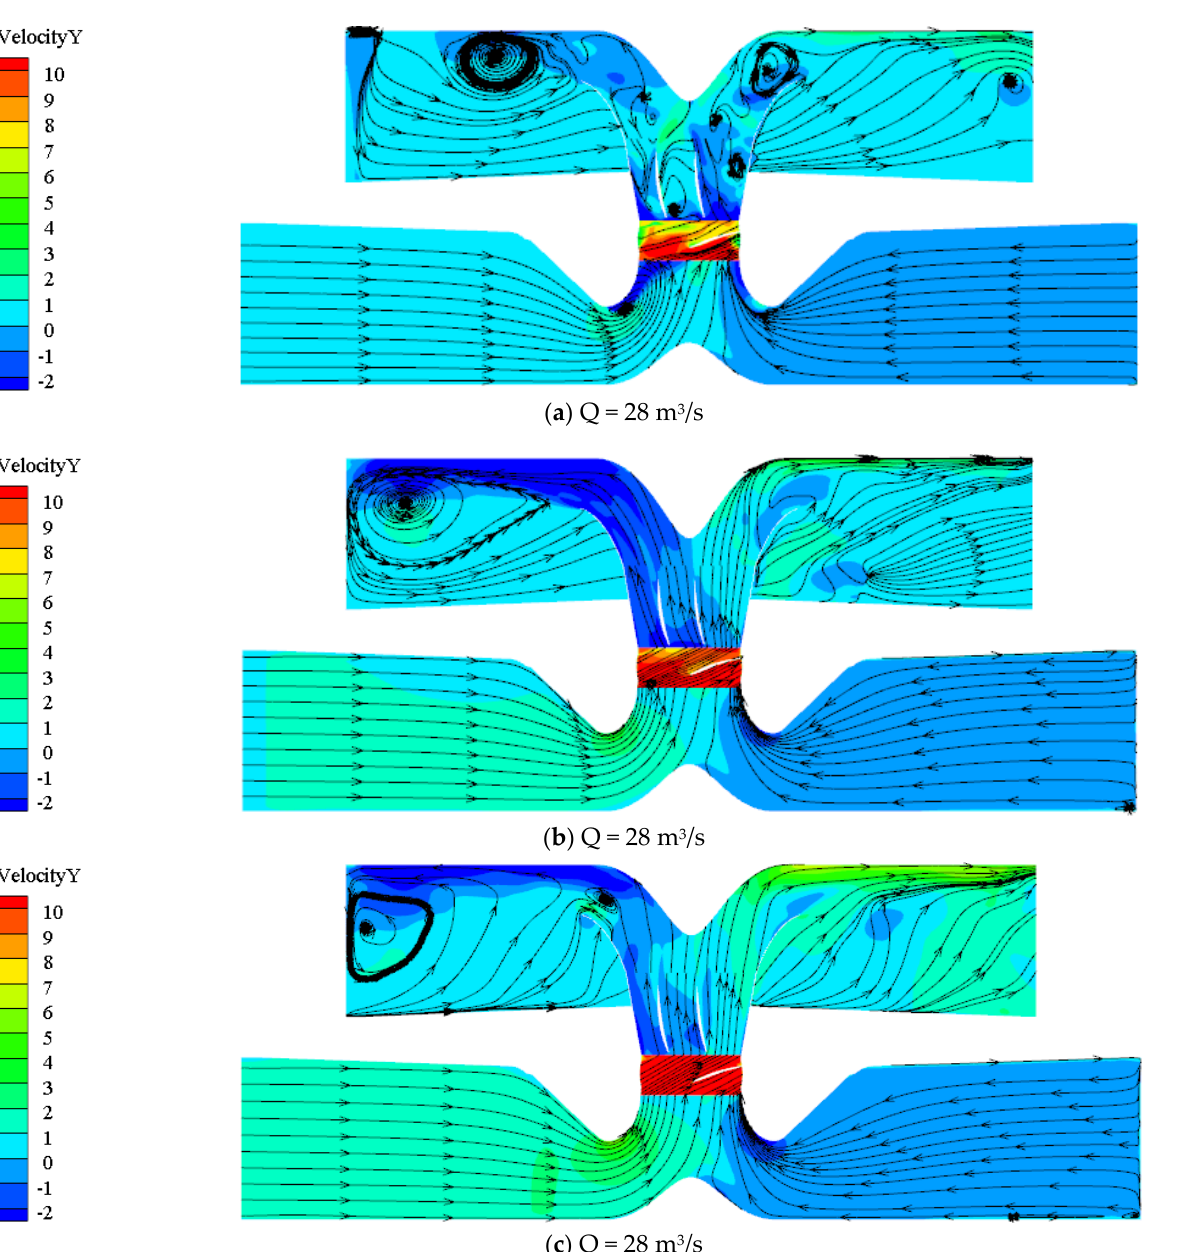
Figure 10. Cross-sectional flow diagrams of flow channels under different working conditions.